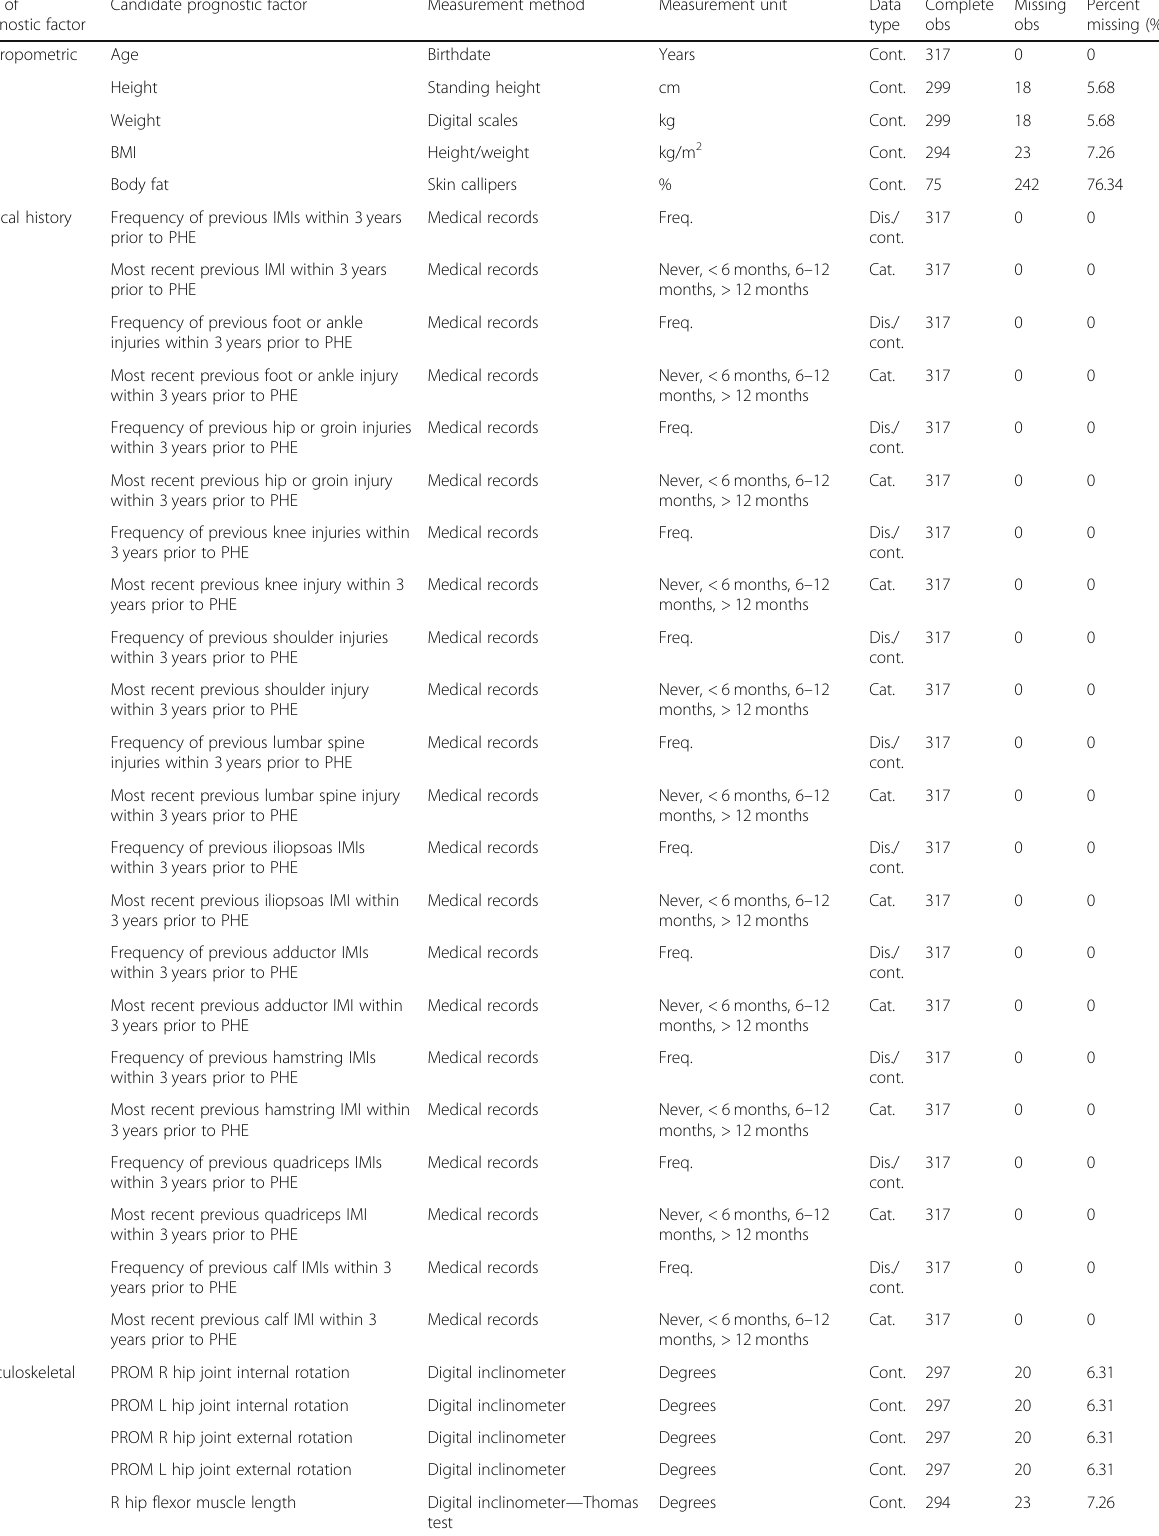
Table 1 List of candidate prognostic factors, methods and units of measurement, frequency of complete and incomplete observations and proportion of missing